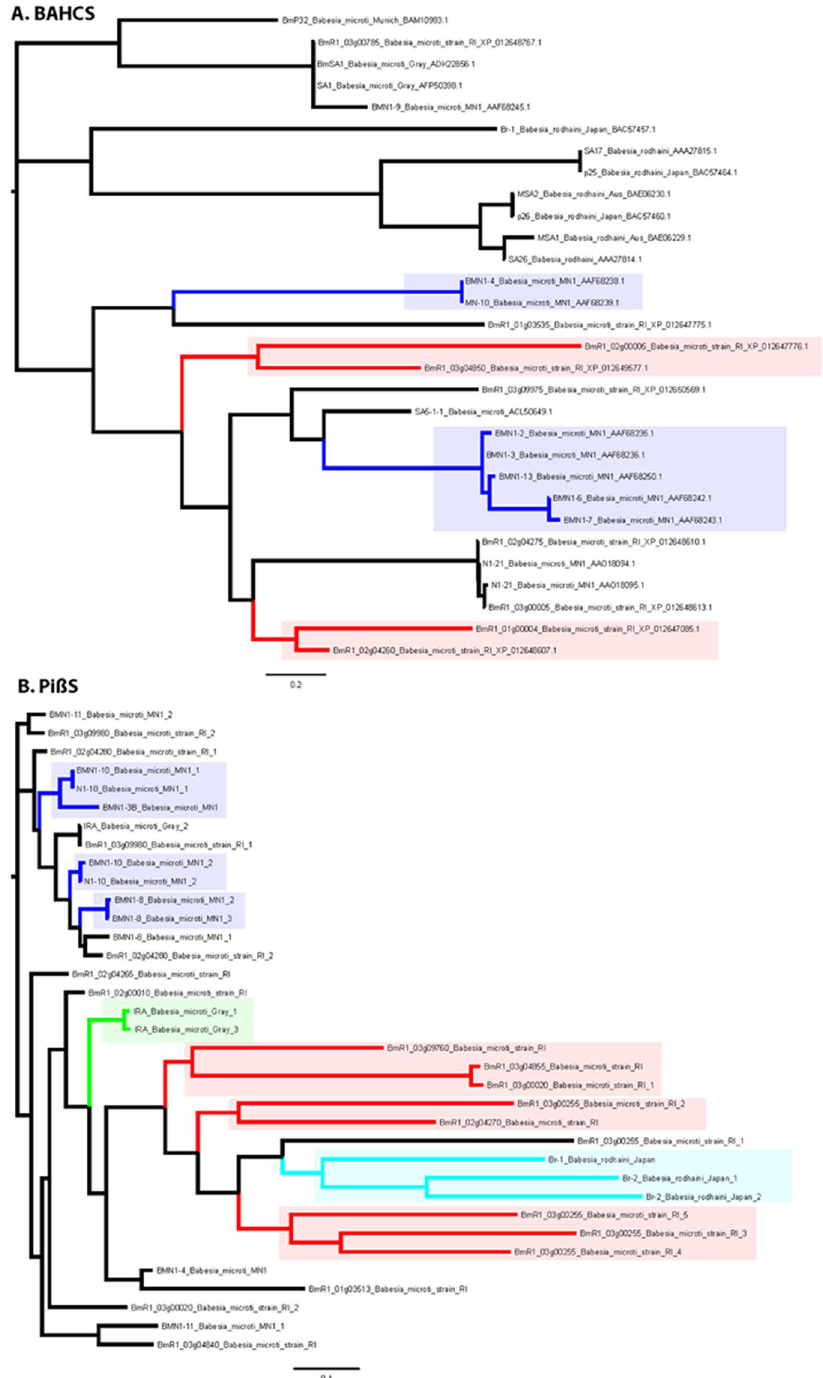
Figure 4. Phylogenetic tree of the (A) BAHCS family (B) BmPi β S1, and other families of proteins. Strain specific clades are shown with colored branches and boxes. B. microti MN1 strain is colored blue, the B. microti R1 strain is colored red, B. microti gray strain is colored green, and the B. rodhaini japan strain is colored light blue. The proteins are denoted by their gene names or gene ids, species names, and accession